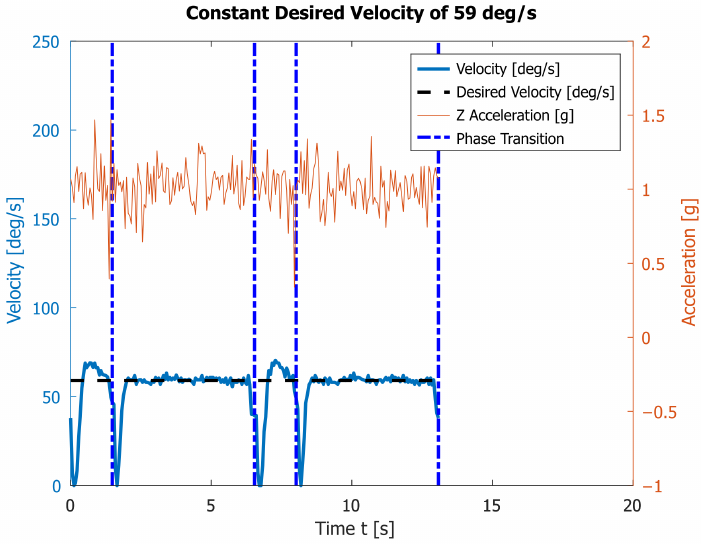
. 𝜔𝜔 1 = 118[° 𝑠𝑠⁄ ] . Figure 8 pre-